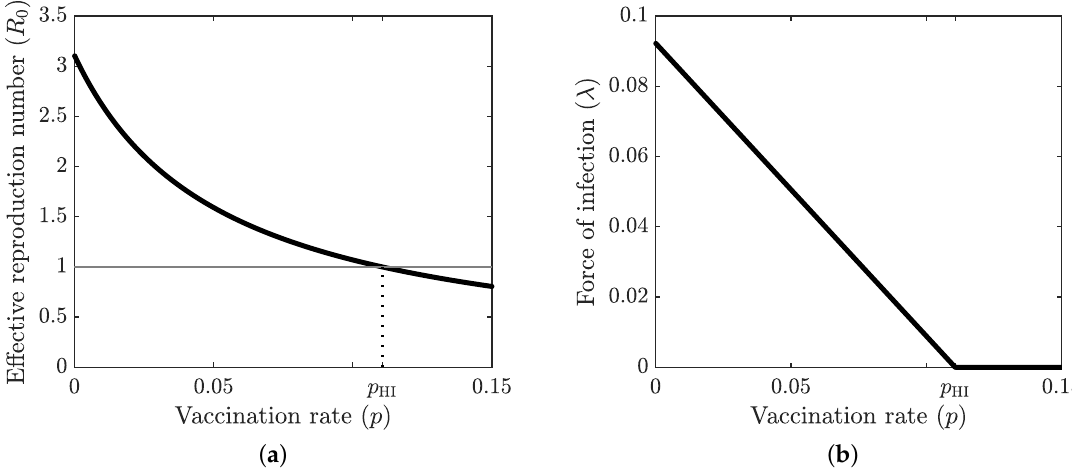
Figure 2. ( a ) Dependence of the effective reproduction number R 0 on the vaccination rate p of susceptible individuals. ( b ) Dependence of the force of infection λ at equilibrium on the vaccination rate p . When p < p HI the equilibrium is endemic, and when p > p HI the equilibrium is disease-free. Parameter values as specified in Table